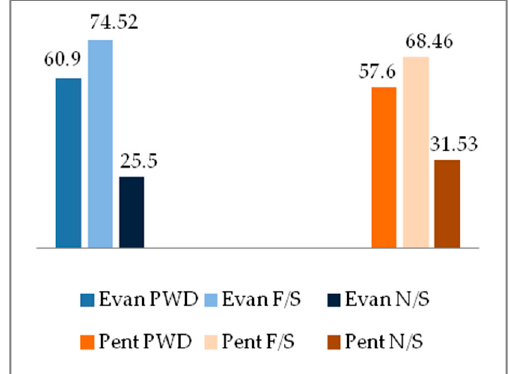
Figure 5. The Caregiver Overall Average % Denominational Shift. Figure 6 Theological Beliefs : The following F/S was noted in the final section of five statements,